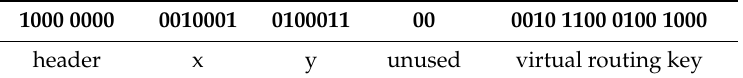
Table 1. Encoding scheme for DVS events.